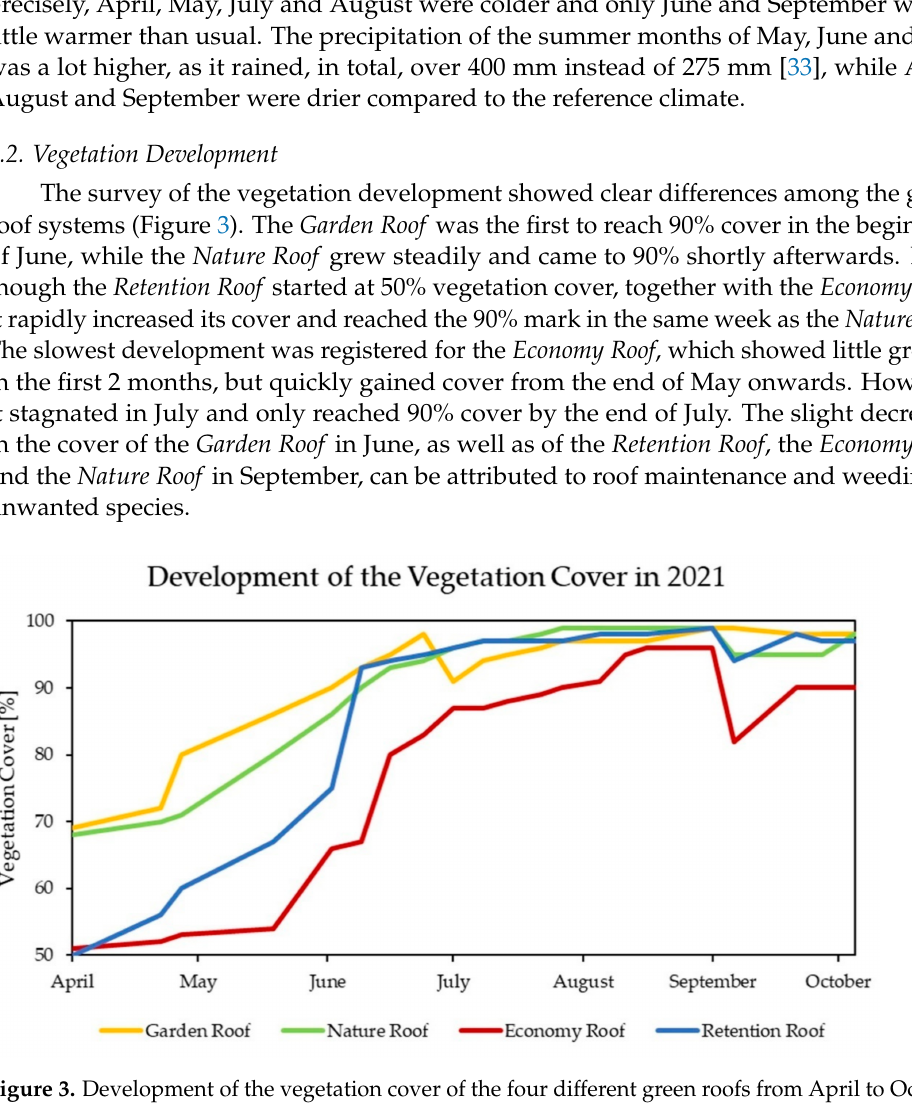
Figure 3. Development of the vegetation cover of the four different green roofs from April to October 2021. Exemplary photos can be found in Appendix A (Figure